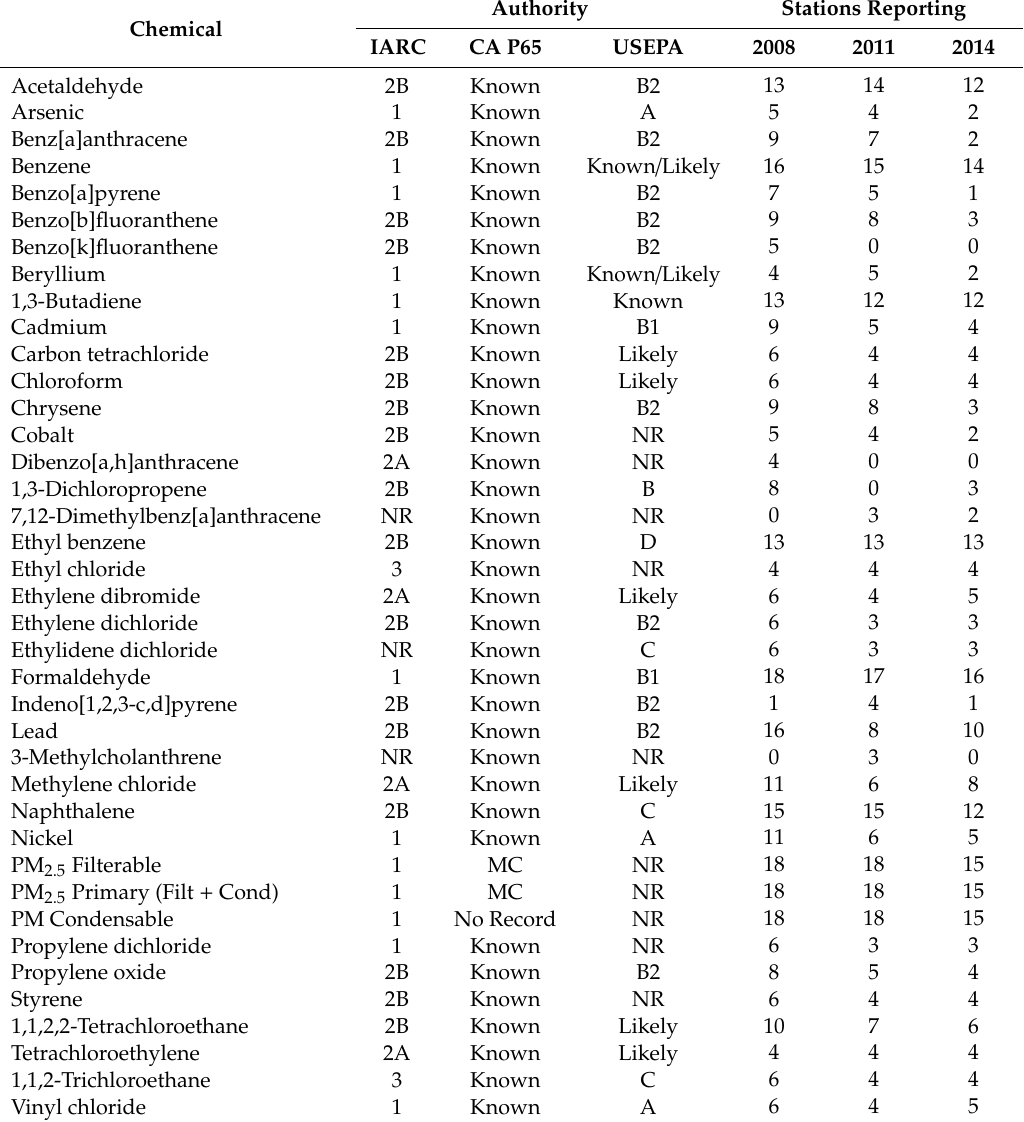
Table 5. Known human carcinogens released by NYS Title-V Compressor Stations.